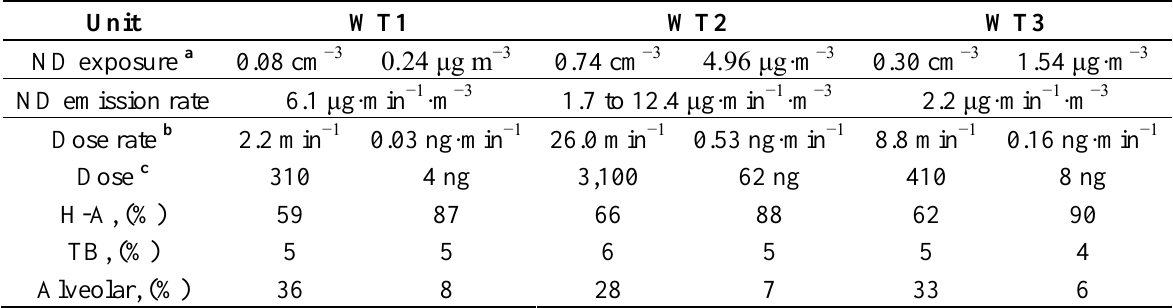
Table 1. ND exposures, emission rates for mass peak concentrations during work tasks, and calculated dose rates, and doses of ND agglomerates to the head-airways (H-A), trachea-bronchiolar (TB), and alveolar regions. The exposure concentration was defined from the SMPS + OPC particle size distributions where particles smaller than 500 nm in diameter were removed. Mass concentration was calculated by assuming that the particles effective density was 0.5 g·cm −3 . The dose was calculated over the time period of respective work